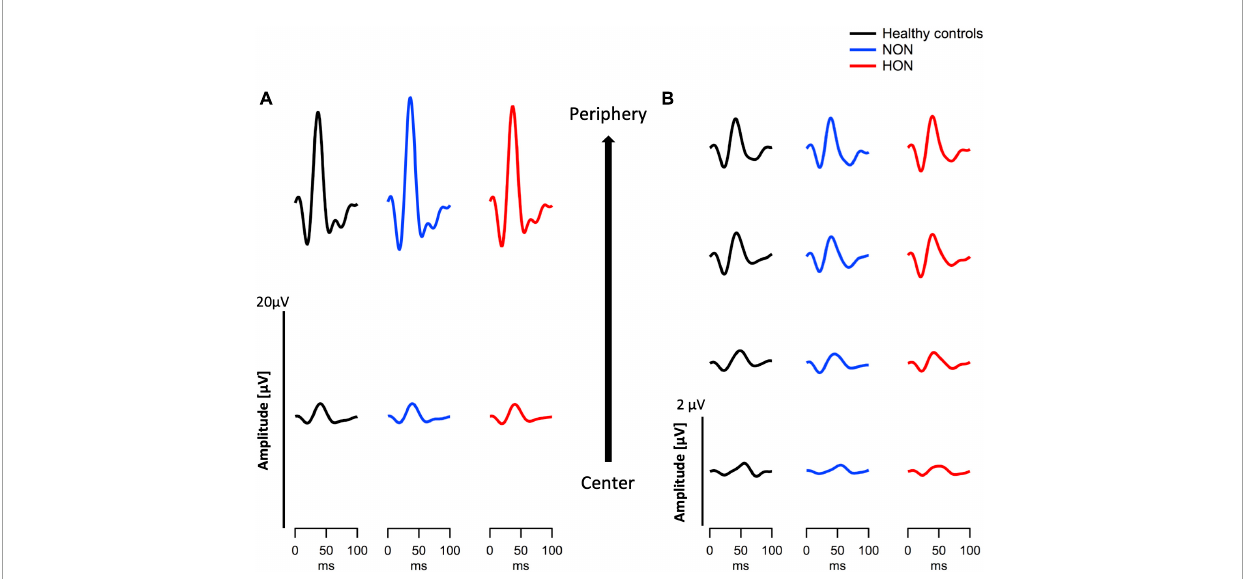
FIGURE2 Eccentricity-based depiction of grand means traces of two modes of electroretinography in the three different groups, healthy, MS with/without optic neuritis, HON vs. NON, respectively. (A) Multifocal electroretinogram (mfERG PhNR ) traces summed in two eccentricities. (B) Multifocal pattern electroretinogram (mfPERG) traces spanning four eccentricities.